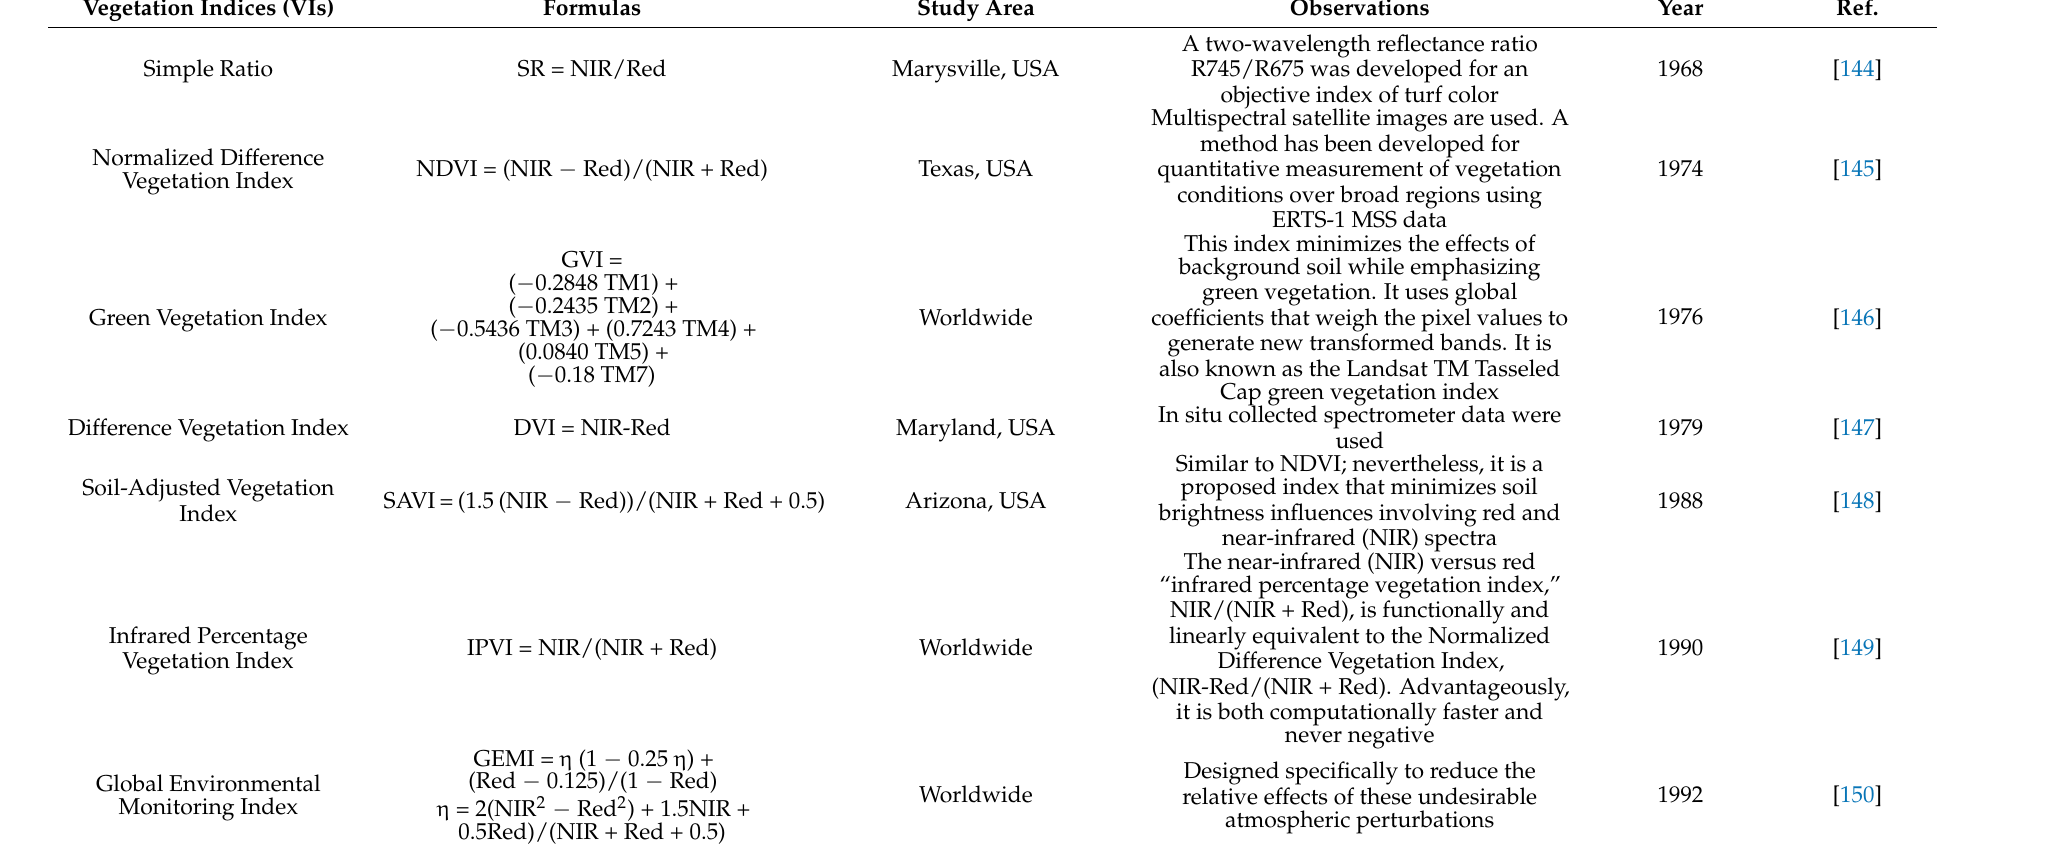
Table A2. The most relevant vegetation indices found in